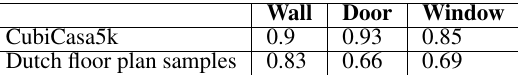
Table 3. F1 scores per type